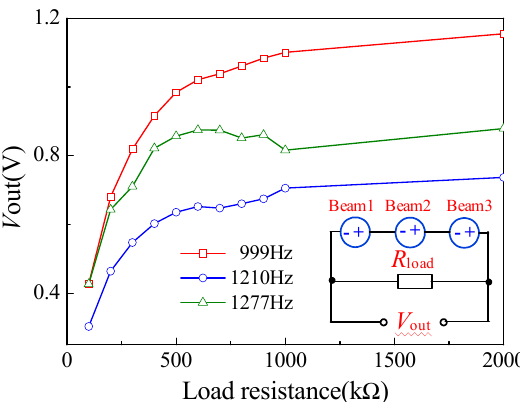
Figure 12. The relationship curves between the load voltage and load resistance of the piezoelectric energy harvester with series connection (inset is equivalent circuit).